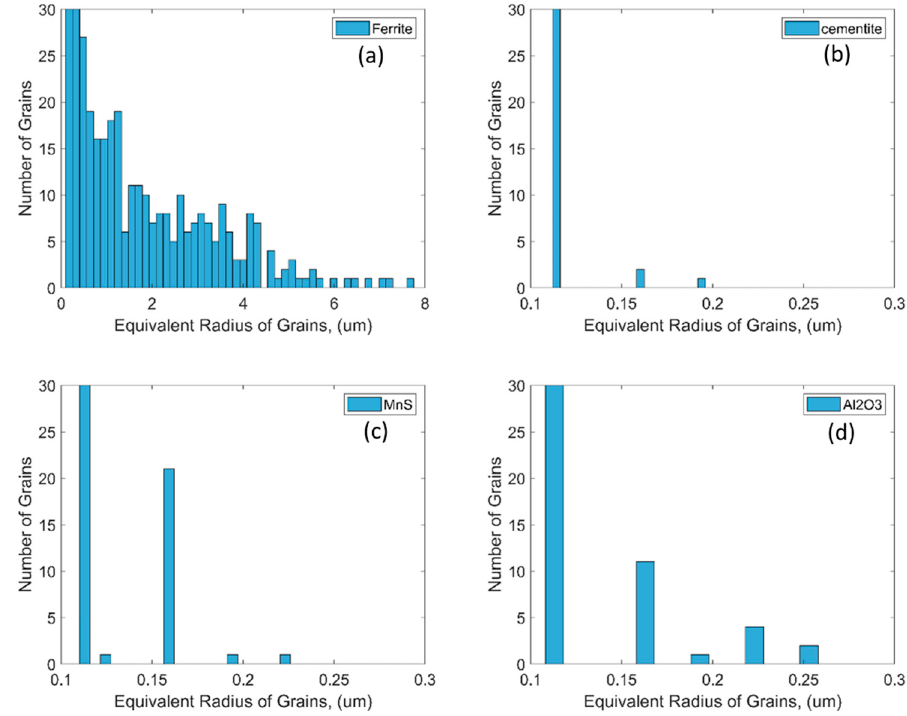
Figure 4. Distribution of grain size in terms of equivalent radius (ER) for ( a ) ferrite, which is biased towards small grains but being widespread reaches up to 8 µ m; ( b ) cementite inclusions, which are generally small with sizes close to 0.1 µ m, with a few inclusions up to 0.18 µ m ER; ( c ) MnS inclusions, which although usually small are in a large number with 0.16 µ m ER and a few as large as 0.23 µ m. ( d ) The Al 2 O 3 inclusions have a large spread with many having sizes close to 0.1 µ m and then having a downslope spread up to 0.25 µ m